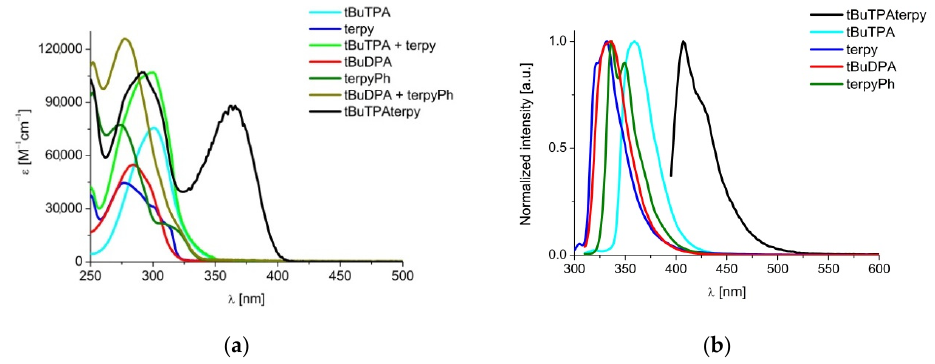
Figure 1. ( a ) Comparison of absorption and ( b ) emission spectra of tBuTPAterpy with its constituent building blocks in n -hexane (c = 10 μ M). building blocks in n -hexane (c = 10 µ M).